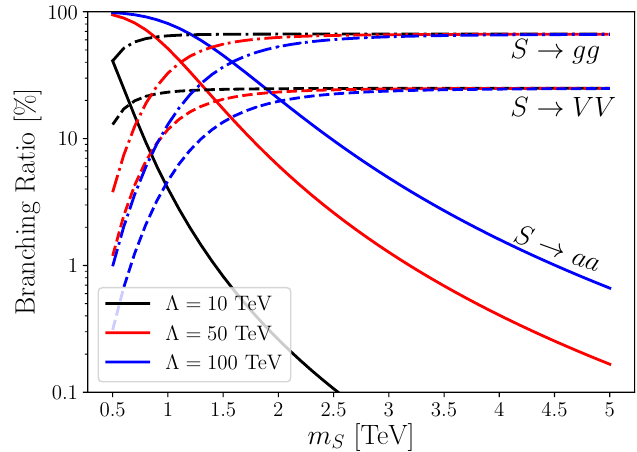
Figure 2 . The branching ratios of the scalar S , as a function of its mass, in the various channels allowed by the interactions of eq. (2.1). We (cid:12)xed m a = 0 : 1 GeV, (cid:3) = 10 TeV, f S = 100 GeV, and c BB = c WW = c GG = 1 to compute these branching ratios. The S ! V V channel represents the combination of the ZZ and WW branching